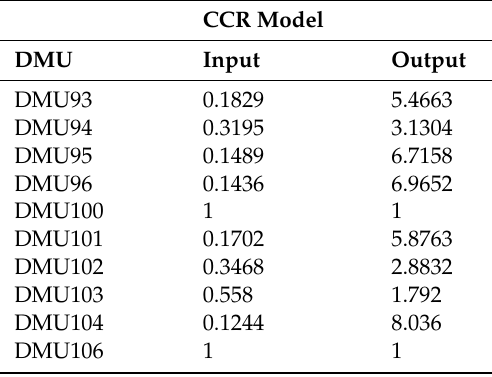
Table 10. CCR method for assessing the e ff ectiveness of furniture